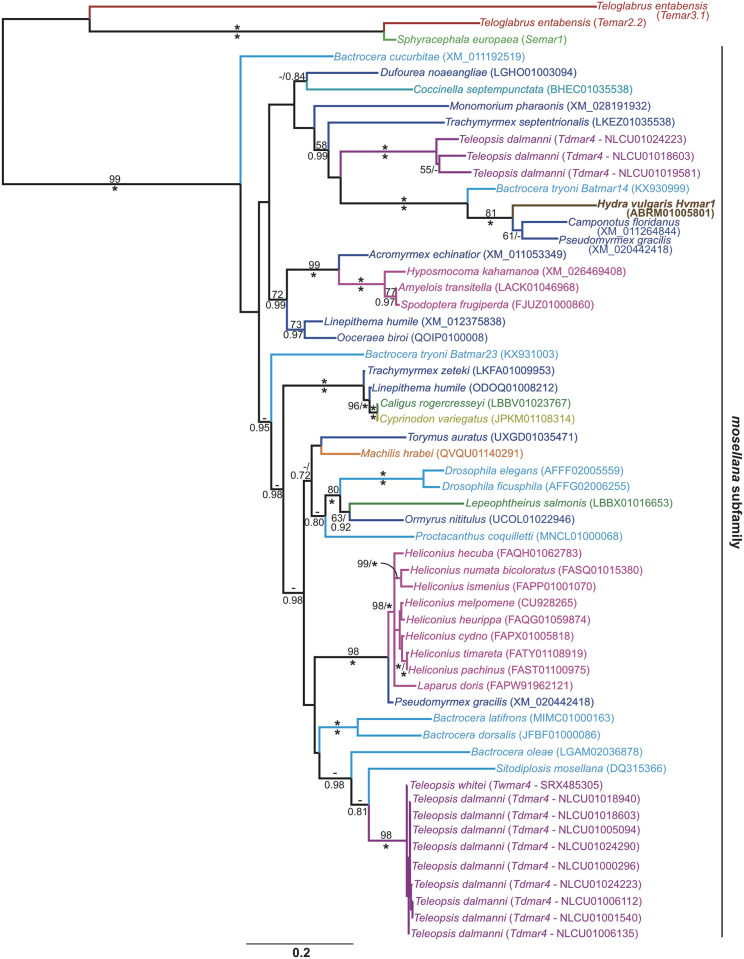
Maximum likelihood phylogeny of the mosellana subfamily.The phylogeny was constructed from 1032 aligned nucleotide positions using the GTRCAT model, and estimated nucleotide frequencies. The mosellana elements are bracketed and rooted with tnpase sequences from the irritans and mellifera subfamilies. Values for mlBP and biPP are shown above and below the branches respectively. Diopsid sequences are shown in purple, other dipteran sequences are shown in light blue. Dark blue sequences are from hymenopteran hosts, pink sequences from lepidopteran hosts, the orange sequence is from an archaeognath host and light green sequences are from copepod hosts. The brown sequence is from a hydrozoan host and the mustard sequence from a fish host. The outgroup sequences are from the irritans subfamily (Semar1 and Temar2.2) and the mellifera subfamily (Temar3.1). 100% mlBP and 1.00 biPP are both denoted by “*”. Values <50% mlBP and <0.70 biPP are denoted by “-”. The scale bar represents the number of substitutions per site.